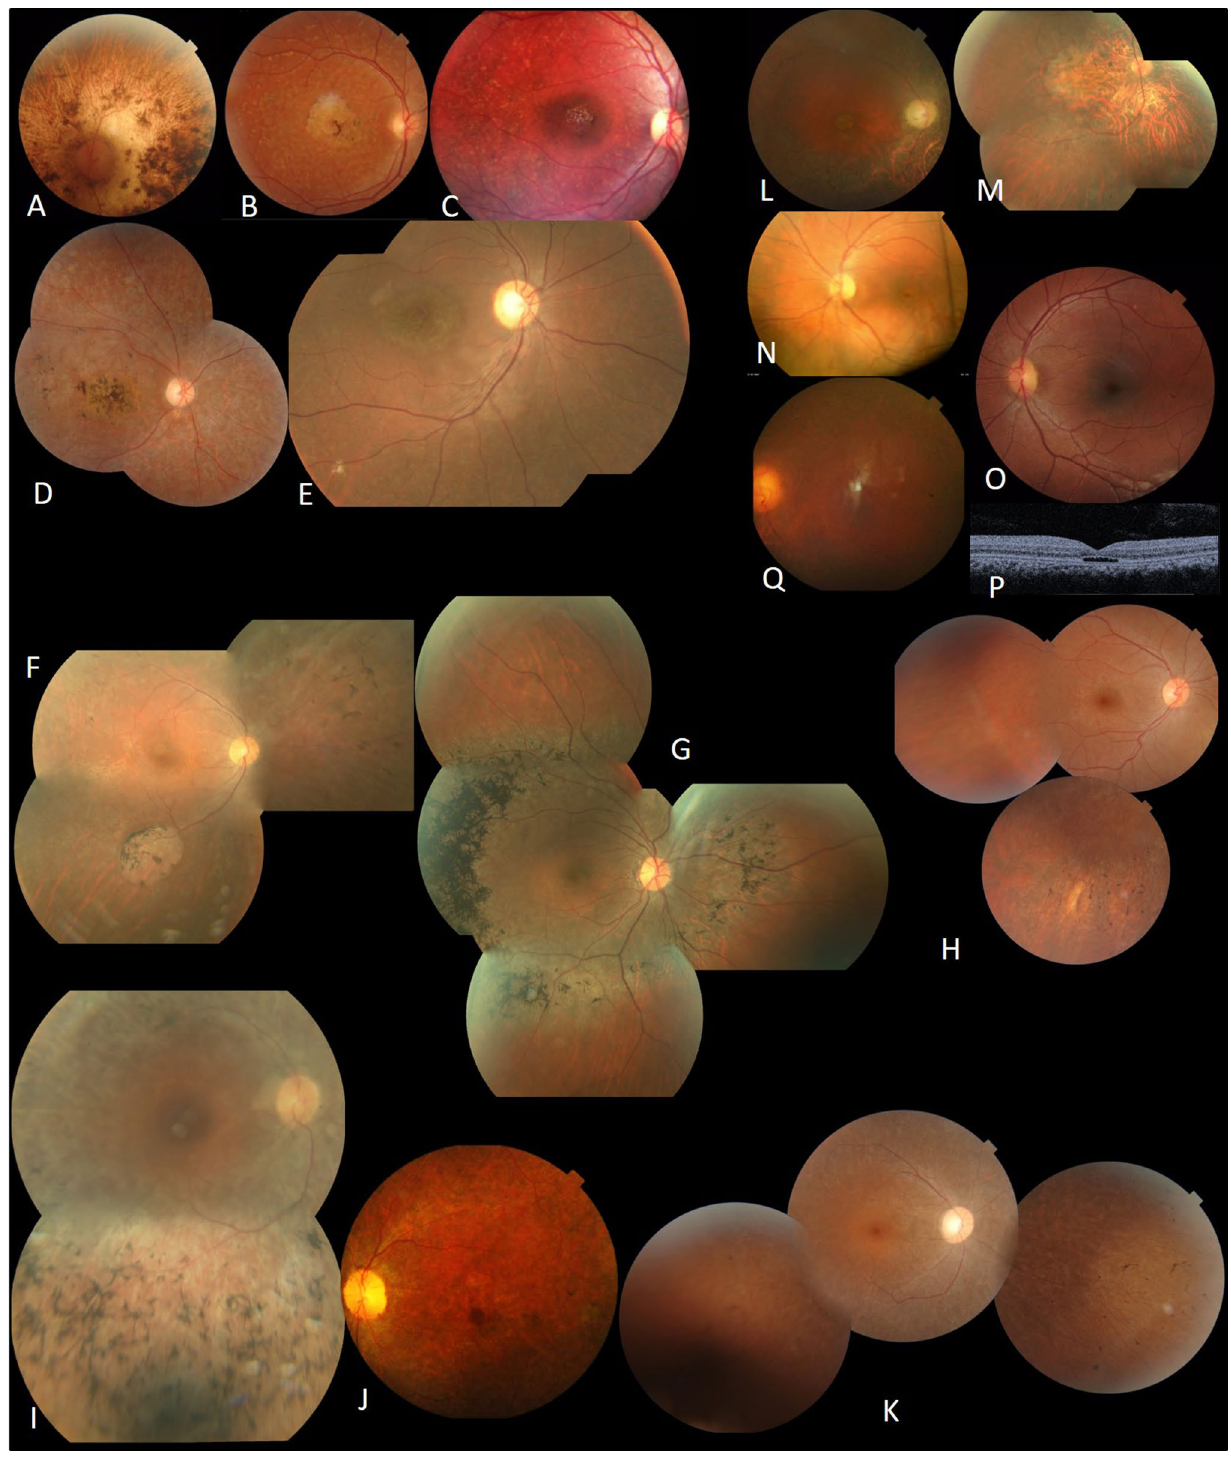
Figure 4. Clinical features of patients with ABCA4 pathogenic variant ( A , B , C , D and E ); RP patients ( F , G , H , I , J and K ); BB patients (L,M); achromatopsia ( N , O , P ) and CSNB ( Q ). A F11, LE fundus of patient II.2. B